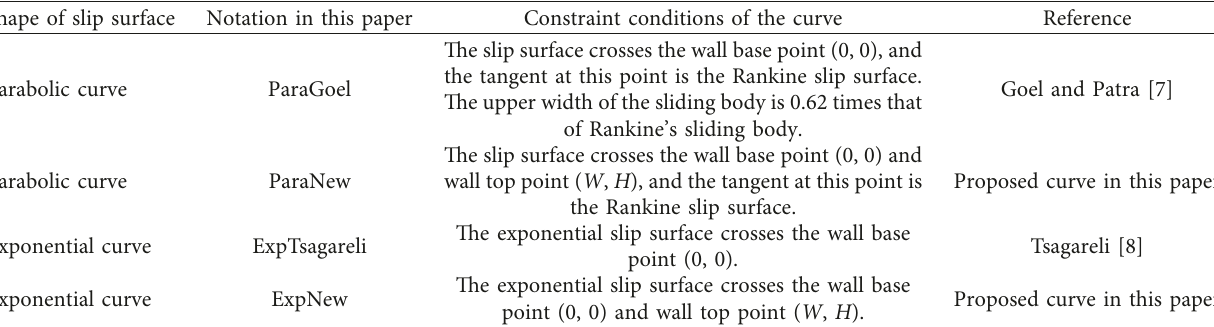
Table 2: Nonlinear sliding curves for comparison with test curves.